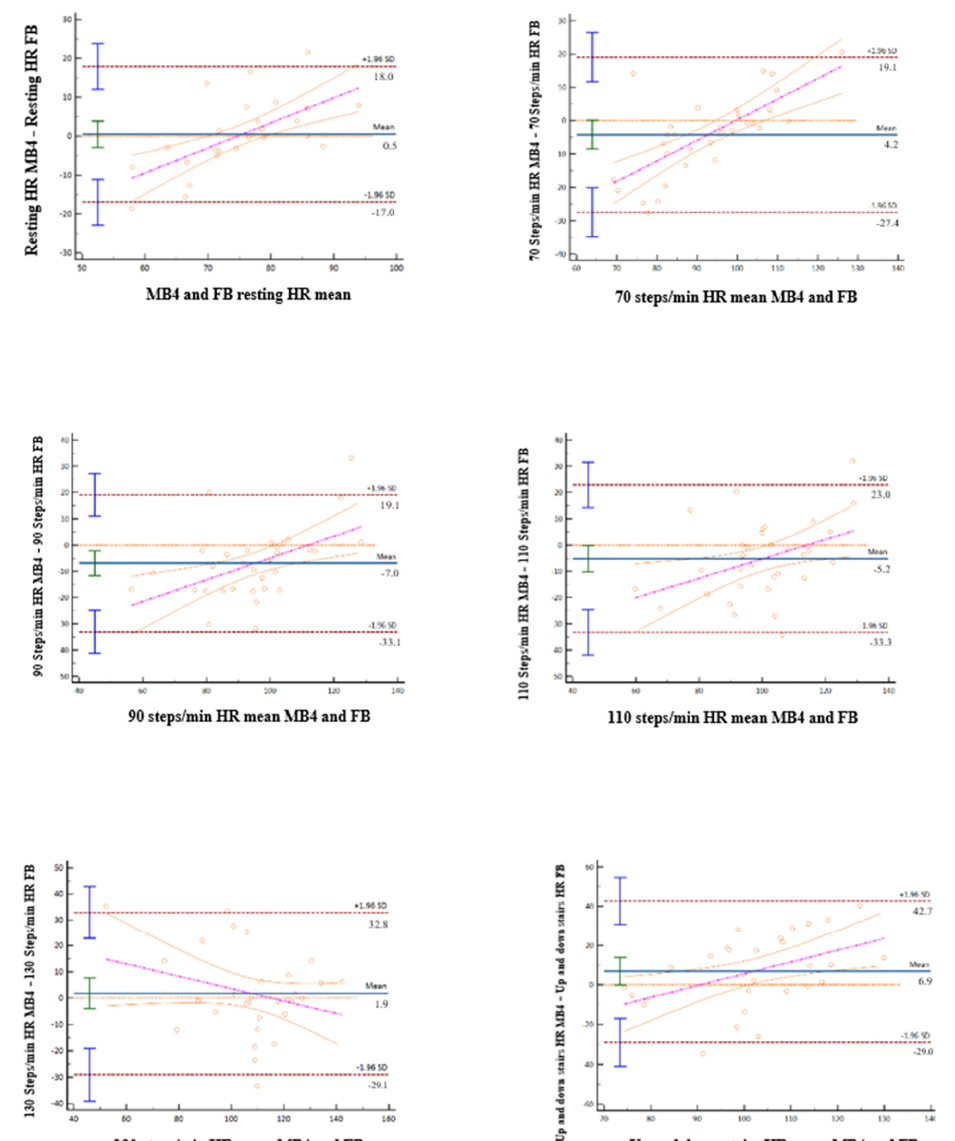
Figure 7. Bland-Altman plots in the process of calculating the concordance between MB4 and FB at rest and in the different gait protocols. rest and in the different gait